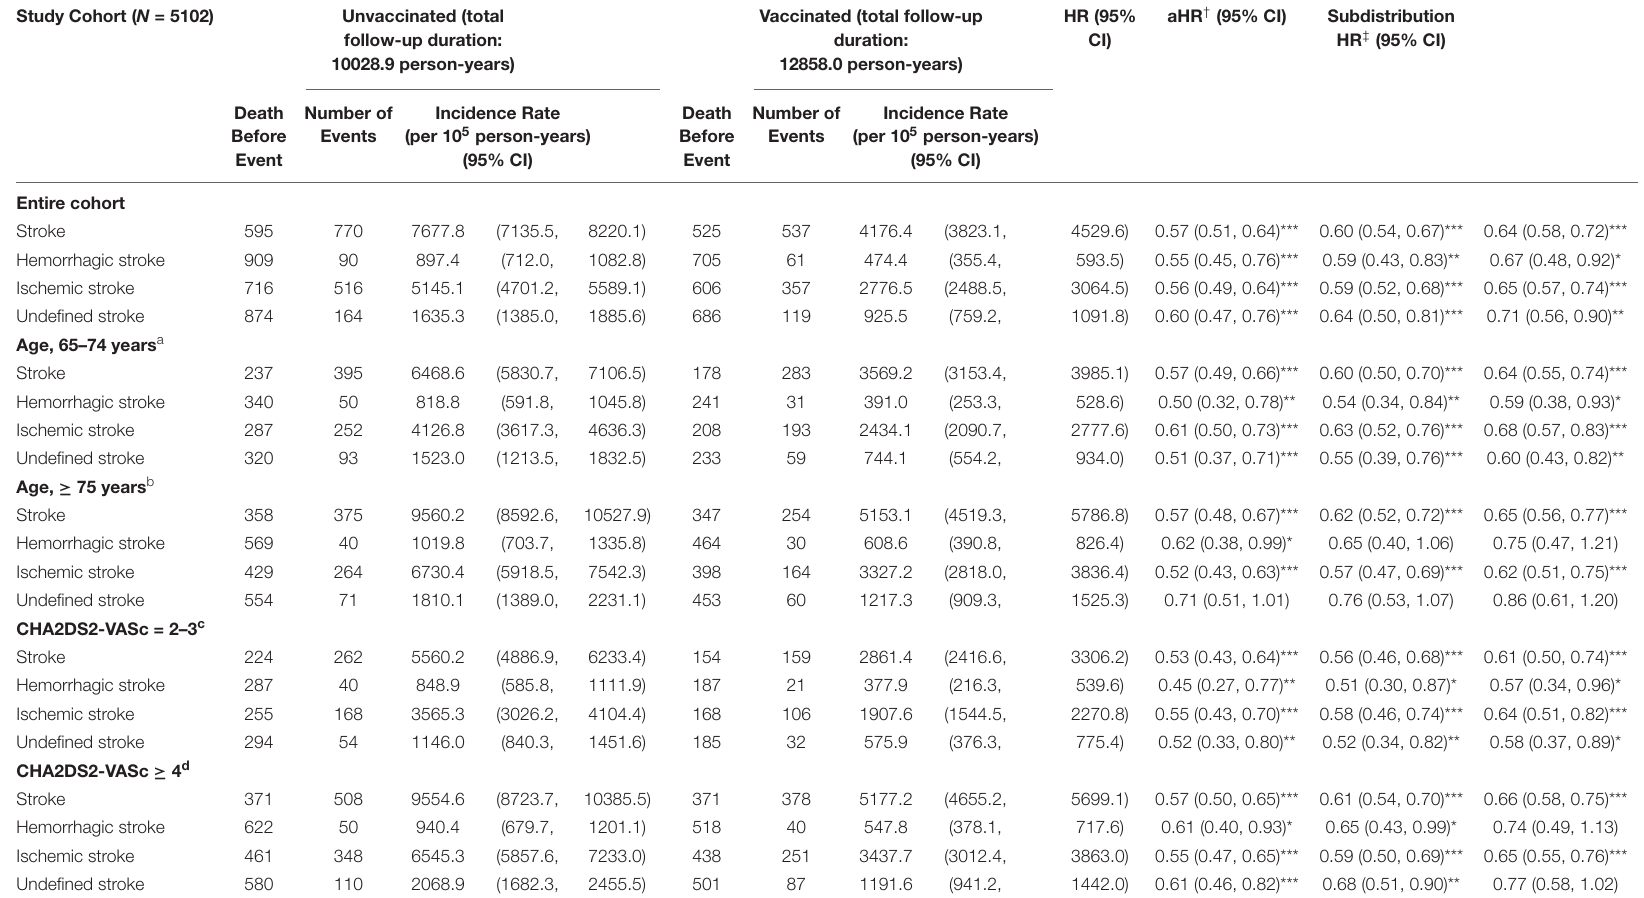
TABLE 2 | Risk of stroke in the unvaccinated and vaccinated groups. Study Cohort ( N =